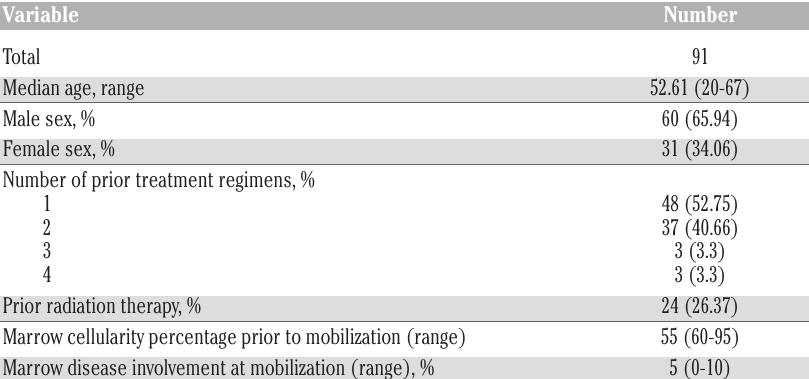
Table 1. Patients’ characteristics.